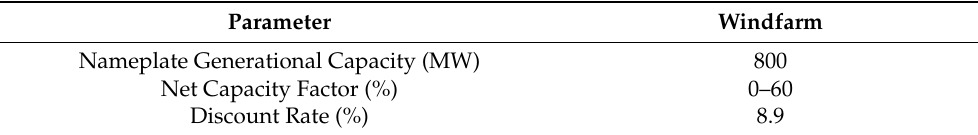
Table 10. Control